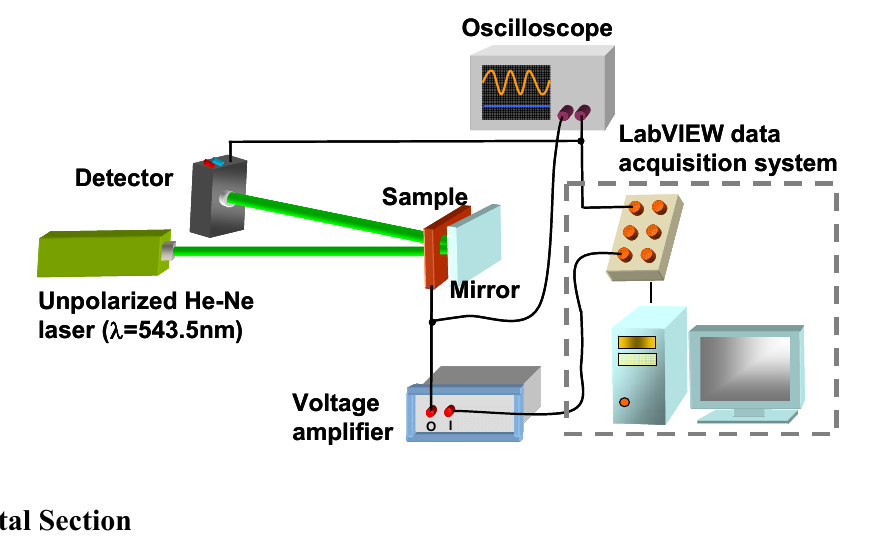
Figure 3. Experimental setup for the reflectance